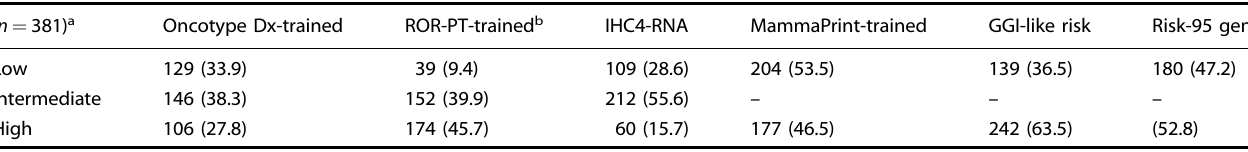
Table 1. Distribution of risk scores by test.